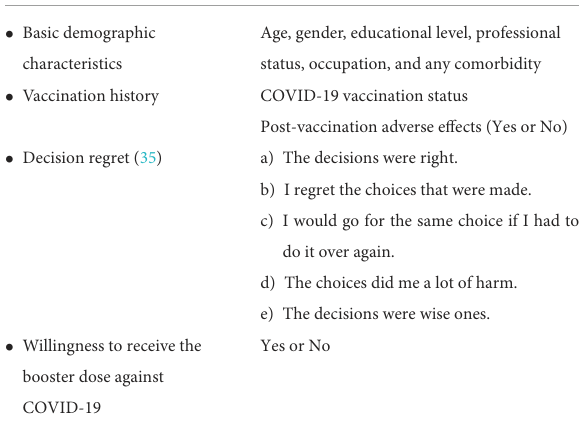
TABLE 1 The main content of the study questionnaire adapted for the proposed